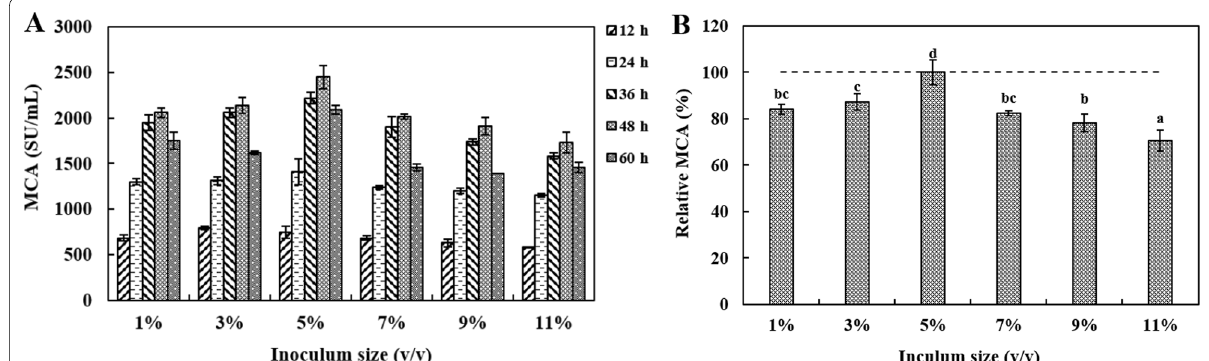
Fig. 5 The effects of inoculum size on DB219 MCE production during different fermentation times (12–60 h). The medium composition was wheat bran (60 g/L), soluble starch (10 g/L) and corn steep liquor (3 g/L). a − d Values in the same row with different superscripts are significantly different ( P < 0.05). The data are represented as mean SD (n 3) ± =